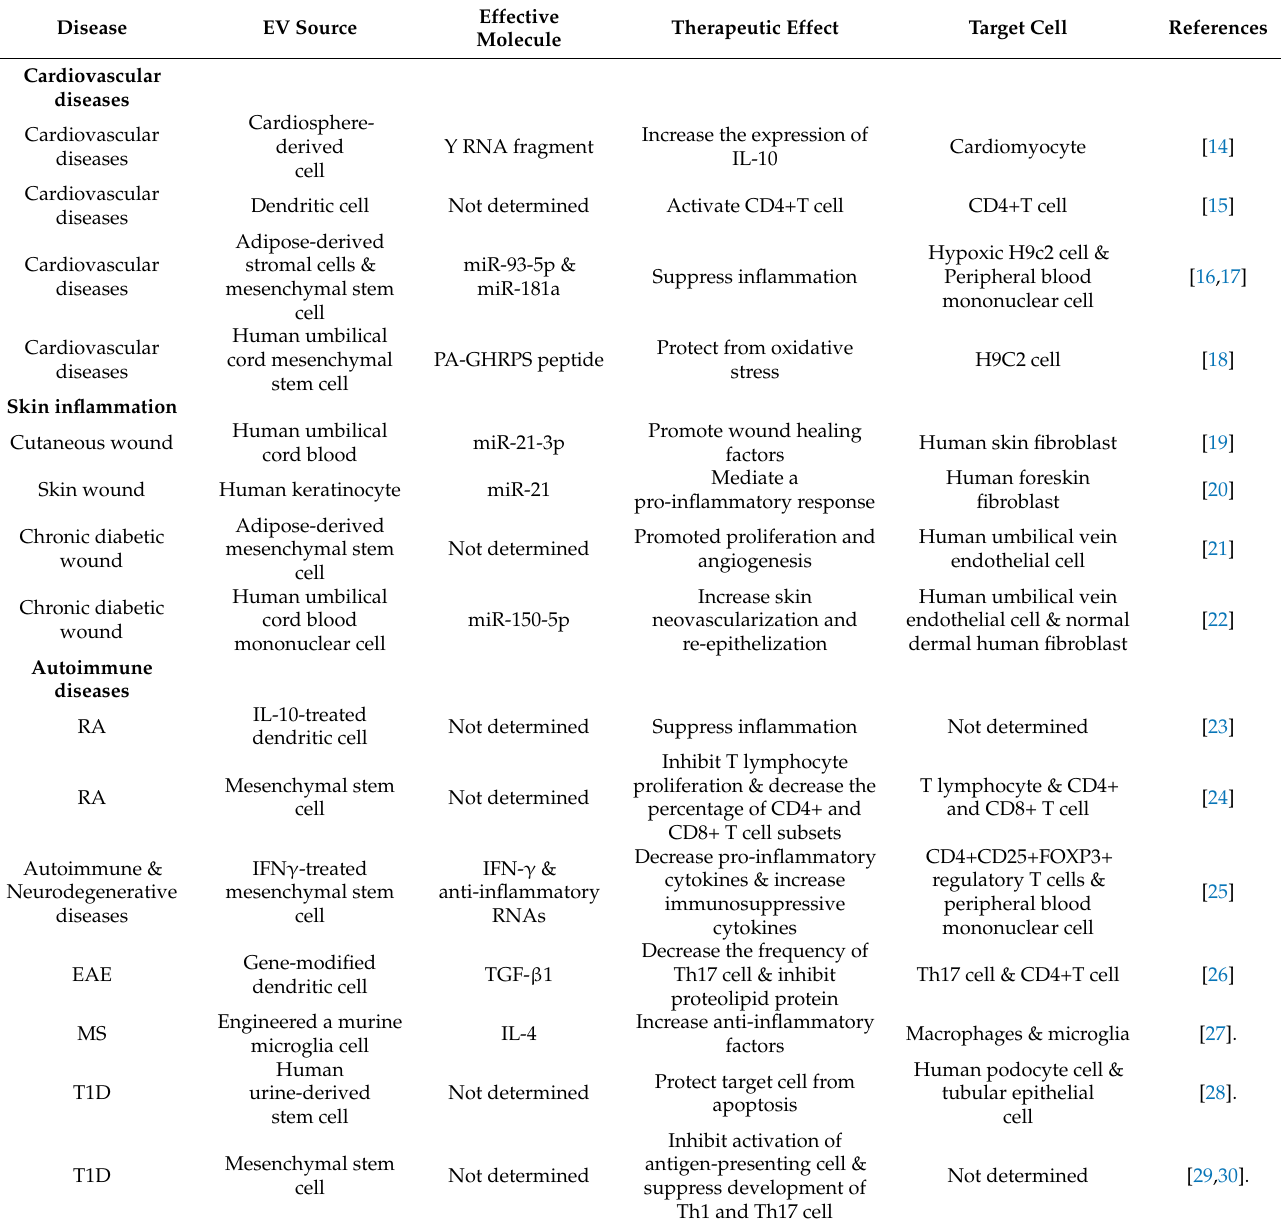
Table 1. Summary of therapeutic potential of extracellular vesicles according to